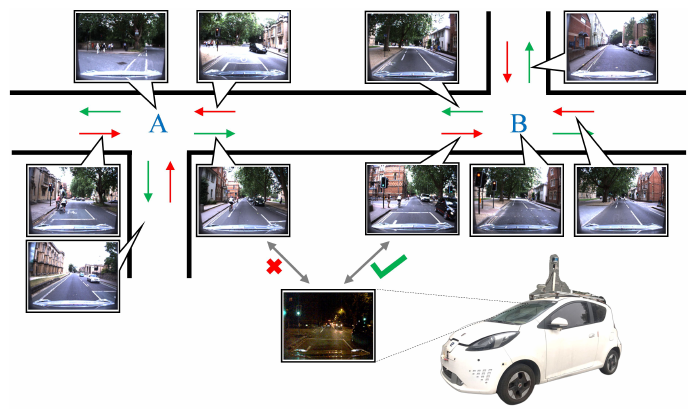
Figure 1. Traffic intersection re-identification for sparse localization of IV. Camera images captured at different positions in each intersection area are mapped and used to extract gallery features, which match the query image to achieve the sparse localization. The gallery images associated with the locations can make up a topological map. Image samples are from